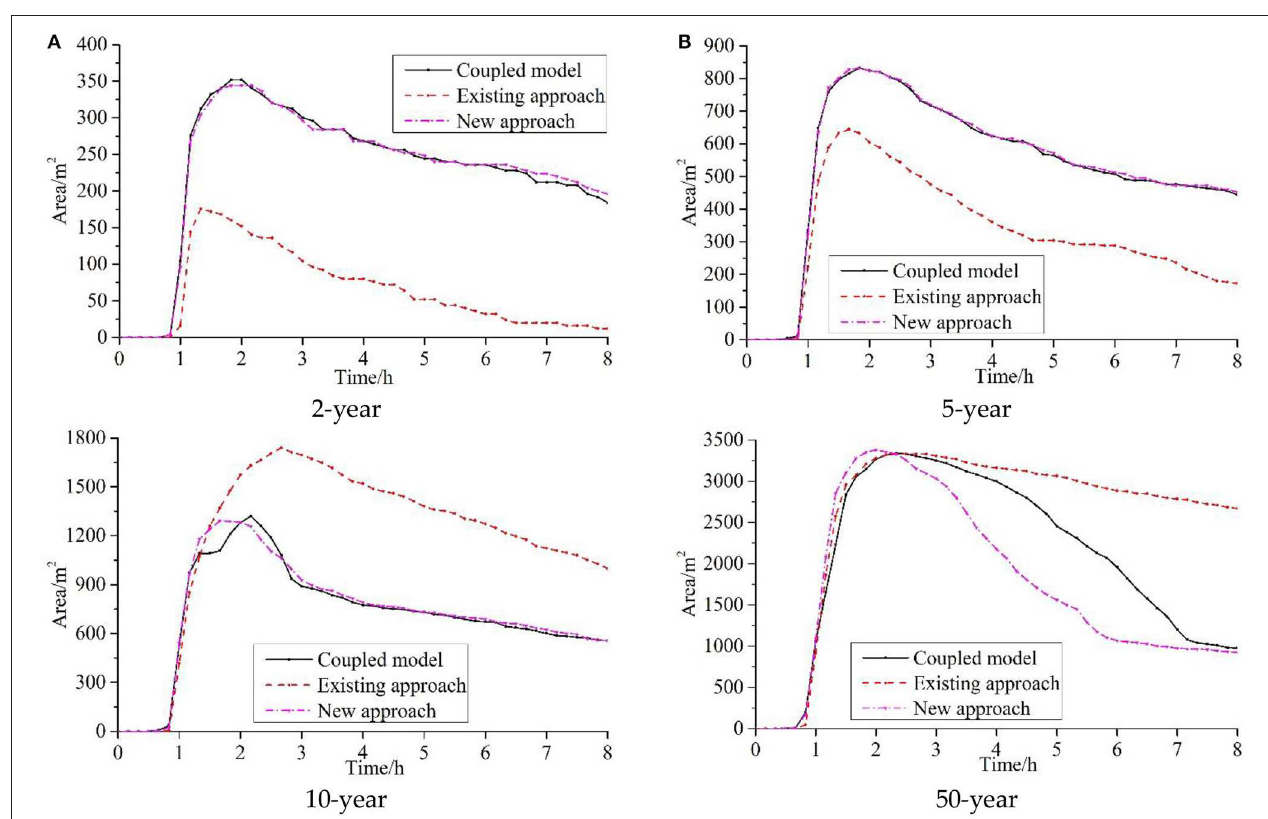
FIGURE 12 | Comparison of inundation extent evolution for different methods ( (A) 2-year, (B) 5-year, (C) 10-year, and (D) 50-year).